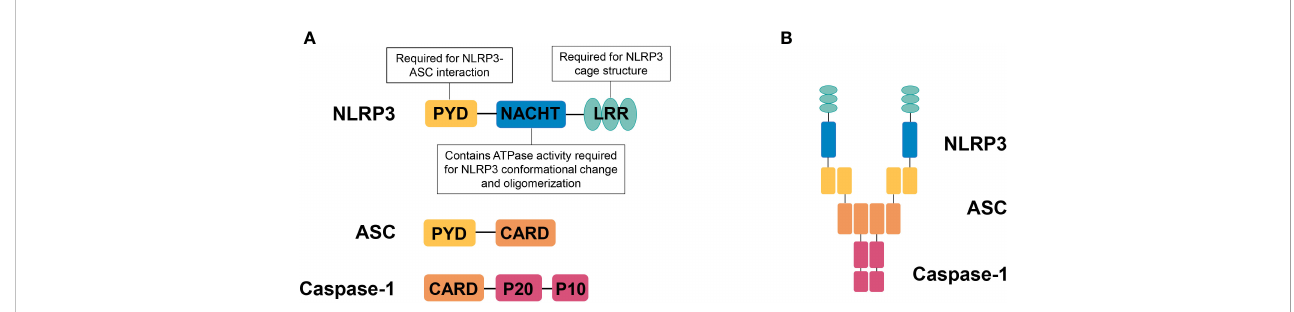
FIGURE 1 NLRP3 in fl ammasome. (A) Domain organization of NLRP3, ASC, and caspase-1. NLRP3 contains an aminoterminal PYRIN (PYD) domain, a nucleotidebinding NACHT domain, and a carboxyterminal leucinerich repeat (LRR) domain. The PYD domain is important for recruitment of ASC; the NACHT domain contains ATPase activity required for NLRP3 conformational change and oligomerization. The LRR domain is important for the formation of the NLRP3 cage, which is required to disperse the trans-Golgi network at the early stage of NLRP3 in fl ammasome activation. (B) NLRP3 in fl ammasome assembly. Upon activation, NLRP3 recruits ASC via PYD-PYD interactions and ASC recruits caspase-1 via CARD-CARD